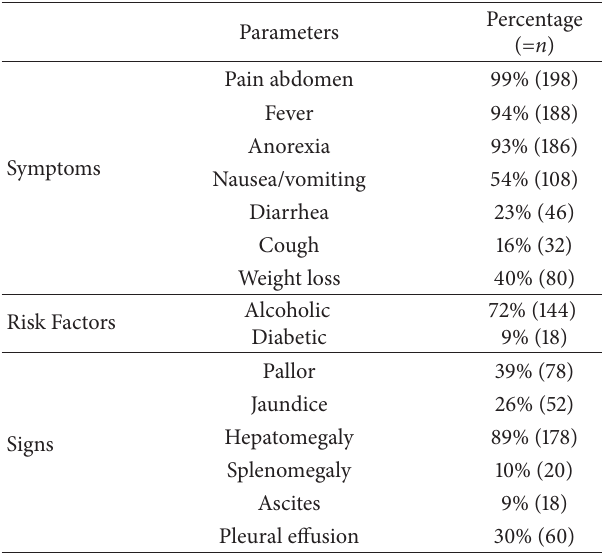
Table 1: Clinical profile of patients: pain abdomen and fever were the two most common symptoms while hepatomegaly was the most frequent clinical